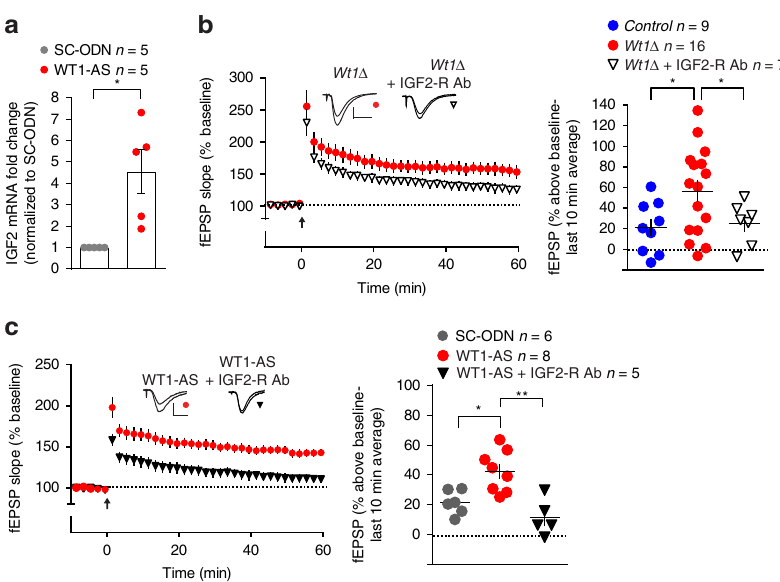
Fig. 5 WT1 effects on hippocampal plasticity are mediated via IGF2. a Quantitative real time PCR showed that WT1 acute knockdown in rats signi fi cantly increases IGF2 mRNA expression (unpaired t test * p = 0.0260). b LTP induced by weak-HFS in Wt1 Δ slices was abolished by bath application of IGF2 receptor antibody (IGF2-R Ab, 5 μ g/ml). Superimposed traces showing representative fEPSPs recorded during baseline and 60 min post-HFS. Calibrations: 0.5 mV/10 ms. Summary of the fi nal 10 min of recording showed that LTP in hippocampal slices from Wt1 Δ mice was signi fi cantly reduced by bath application of IGF2-R Ab (two-way ANOVA RM, * p = 0.0430, F (1, 13) = 5.03). For ease of comparison data for the Control and the Wt1 Δ group in the bar graph are the same as in Fig. 3g. c WT1-AS-mediated LTP enhancement was blocked by bath application of IGF2 receptor antibody (IGF2-R Ab, 5 μ g/ml). Representative fEPSPs show superimposed traces recorded during baseline and 60 min post-HFS. Calibrations: 0.5 mV/10 ms. Final 10 min of recording showed that LTP in WT1-AS injected slices was signi fi cantly reduced by IGF2-R Ab (two-way ANOVA RM, ** p = 0.0017; F (1, 11) = 16.85). For ease of comparison data for the SC-ODN and the WT1-AS groups, in both the time course and bar graph, are the same that is shown in Fig. 3d. Data are expressed as mean ±